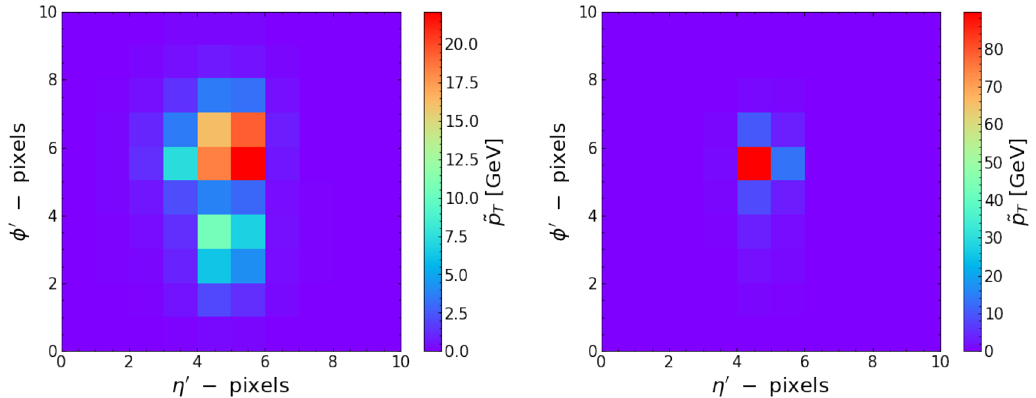
Figure 7 . The left panel shows the top-signal image on the modified η − φ plane, and the right panel shows the same for the QCD background. The image has been cropped and downsampled from the original by averaging four square pixels; hence the colour of each pixel represents the average transverse momentum of the original four pixels. Each image consists of an average of 5 , 000